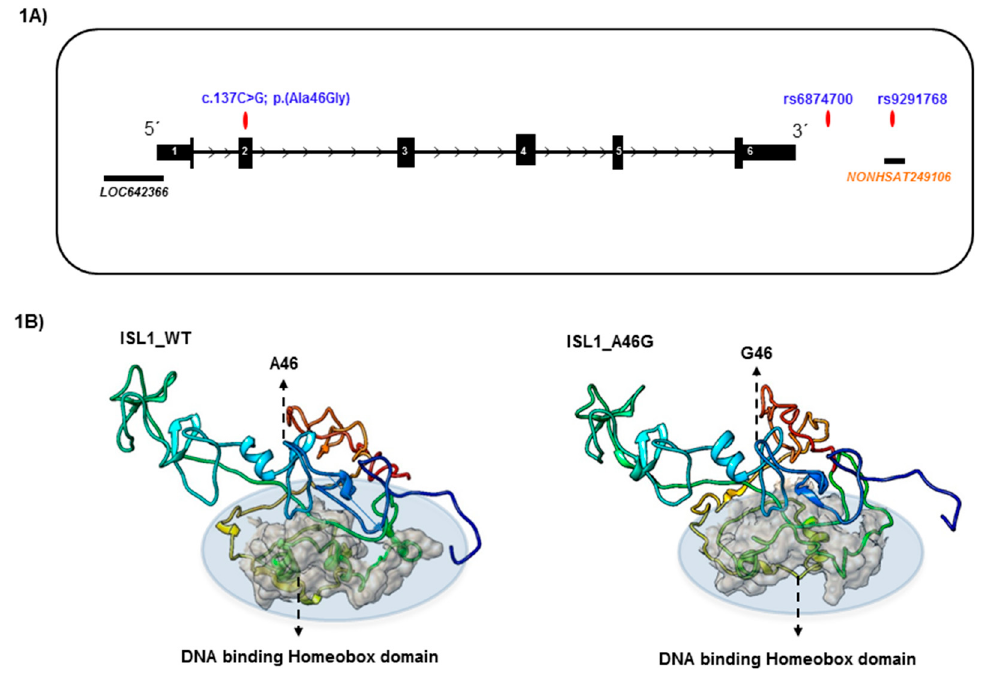
Figure 1. Characterization of ISL1 genomic variants. ( A ) The exon/intron structure of ISL1 with genomic variants is presented. ( B ) Structural modeling of ISL1 wild type and c.137C > G (p.Ala46Gly)) mutant protein.